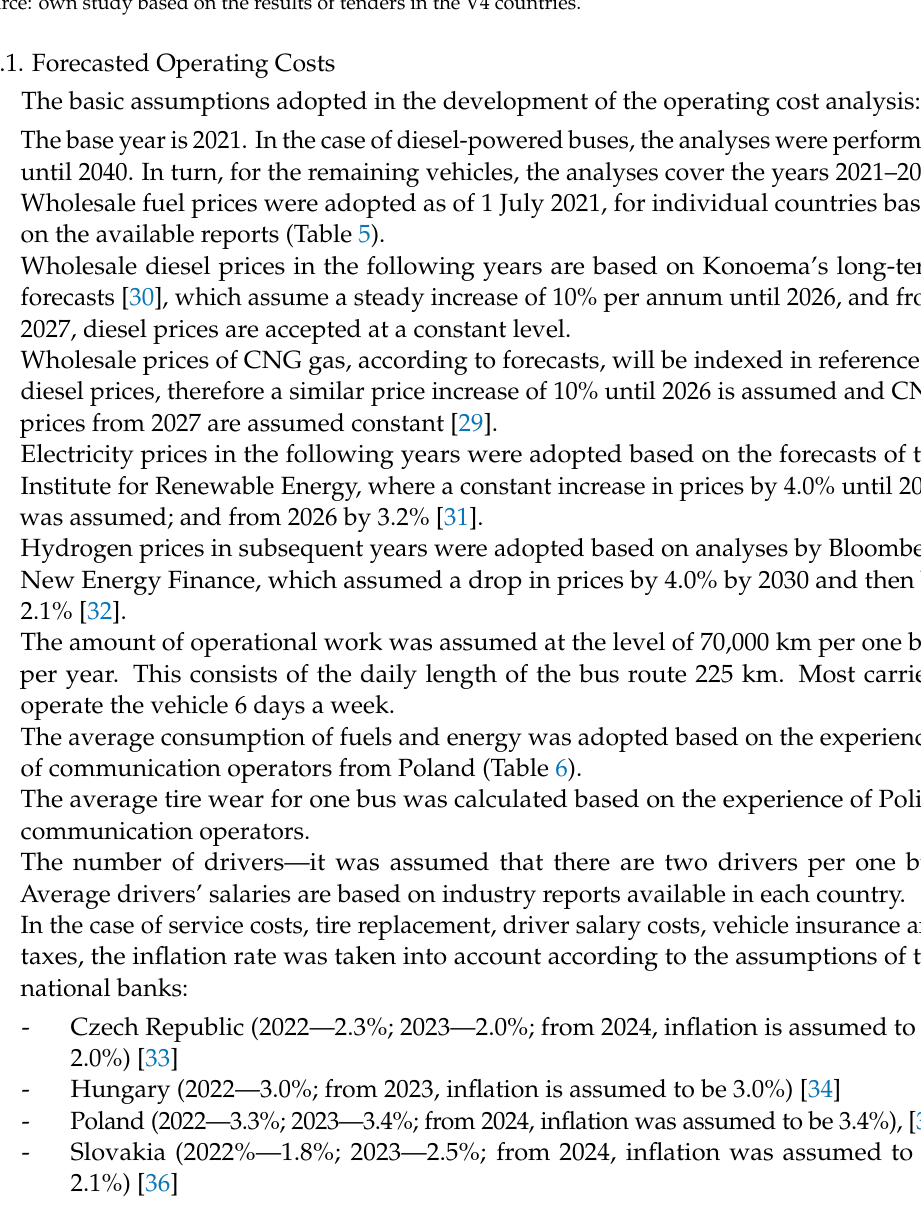
Table 5. Wholesale fuel prices in the V4 countries as of 1 July 2021 ( € ). Fuel